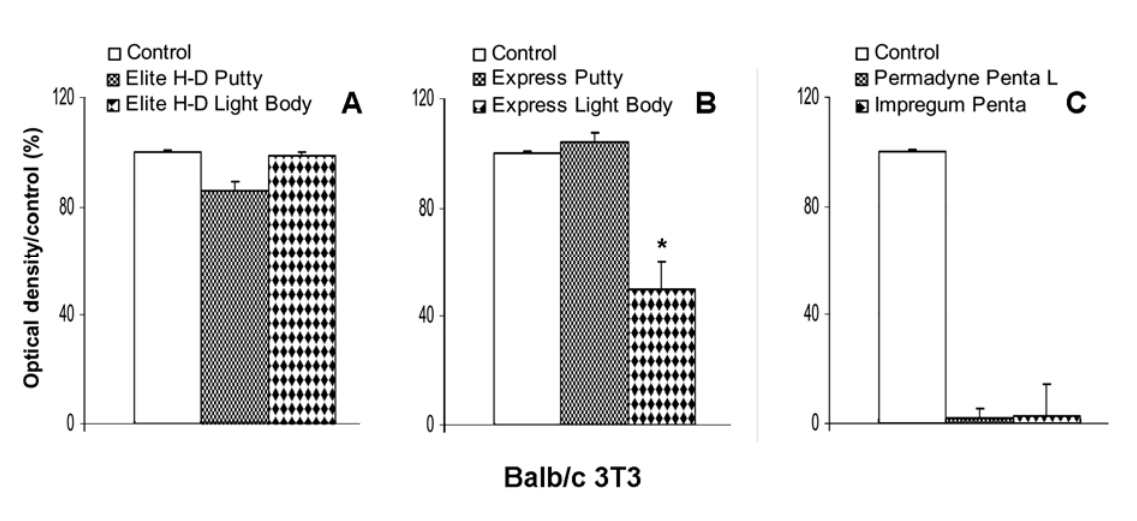
Figure 3. Indirect effect of eluates of vinylpolysiloxane - Elite H-D Putty, Elite H-D Light Body, Figure (A), Express Putty and Express Light Body (B) - Permadyne Penta L and Impregum Penta (C) obtained after 24h of incubation on viability (evaluated by MTT tests) of Balb/c 3T3 cells. The data are expressed as a percentage of optical density (±SE) compared with the untreated cells. Each graph averages the results from at least four measurements. *P <0.05. One way ANOVA test and Bonferroni multiple comparison